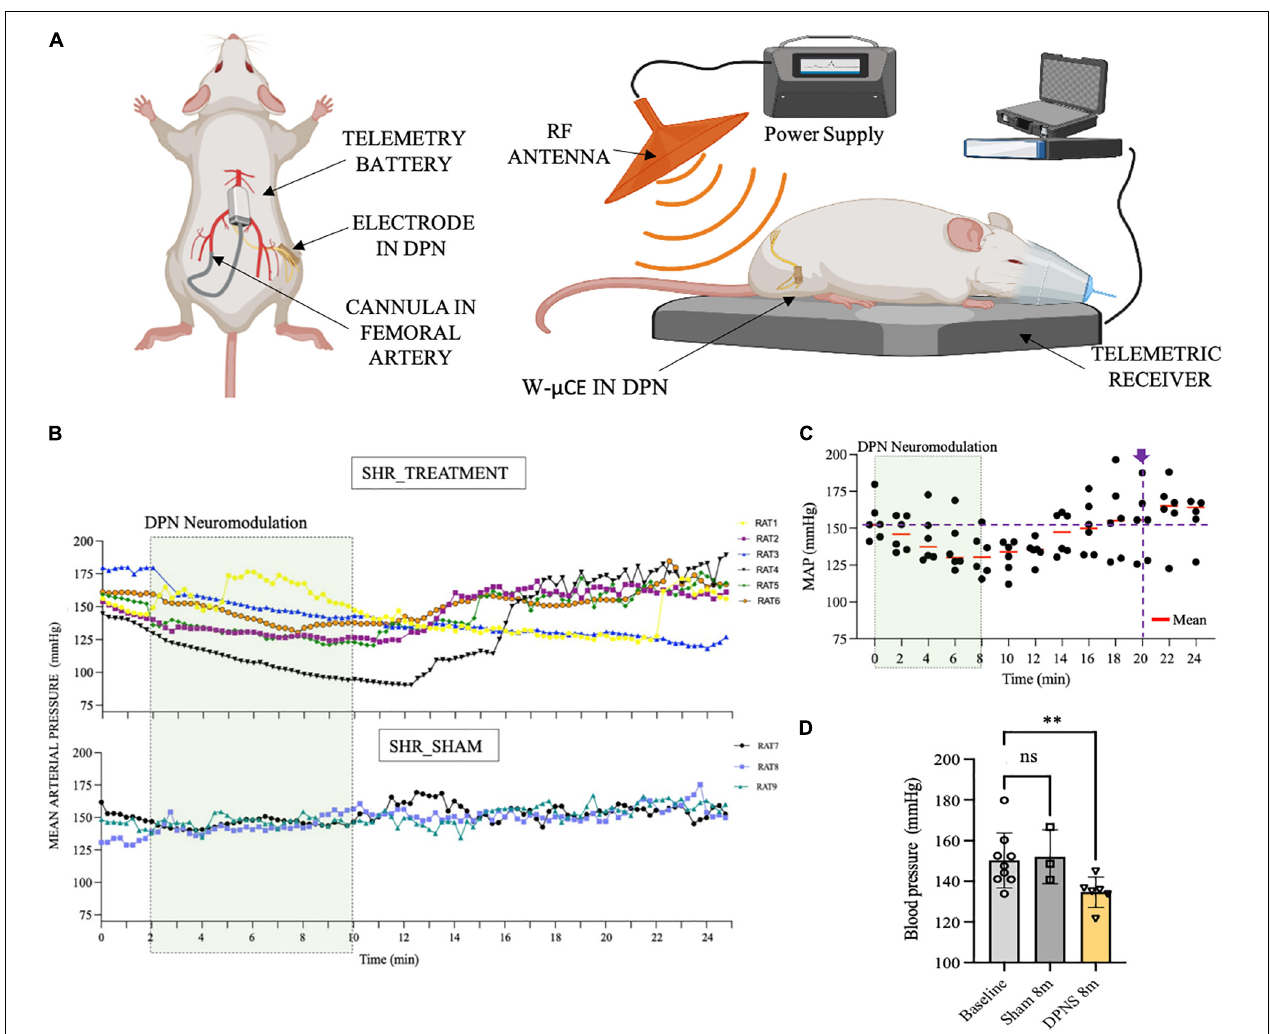
FIGURE 5 | Effect of sub-chronic DPNS on mean arterial pressure in SHR animals. (A) Experimental setup; mean arterial pressure was measured with a telemetric device from the femoral artery. The external RF antenna delivered pulses to the w-mCE on the DPN. (B) Mean arterial pressure modulation by DPN stimulation, at day 21 of implantation ( n = 6 SHR animals treated, n = 3 SHR sham). At baseline, all animals showed MAP values of (150 ± 14 mmHg; n = 9); the shadowed square represents the period of stimulation. SHR treated showed a decrease from 159 to 128 mmHg ( n = 6), while the sham group maintained a MAP of 150 ± 13 mmHg ( n = 3). (C) Individual datapoints of SHR with an active w- µ CE ( n = 6) with their means obtained every 2 min. The depressor response progressively returned to baseline levels at minute 20 from the start of the stimulation (164 ± 26 mmHg). (D) Effect of DPN stimulation at minute 8 significantly reduced the MAP (** p < 0.004 one-way ANOVA followed by Dunnett’s test) in the DPNS-treated group (135 ± 8 mm Hg; n = 6), while MAP values were similar in sham animals (150 ± 13 mm Hg; n = 3). DPN, deep peroneal nerve; DPNS, DPN stimulation; RF, radio frequency; SHR, spontaneous hypertense rats; w-mCE, wireless micro-channel